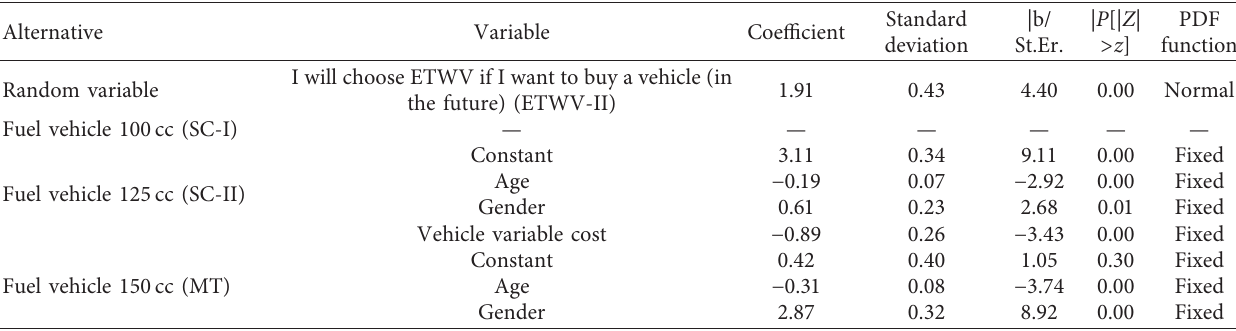
Table 7: Estimation results of MXL